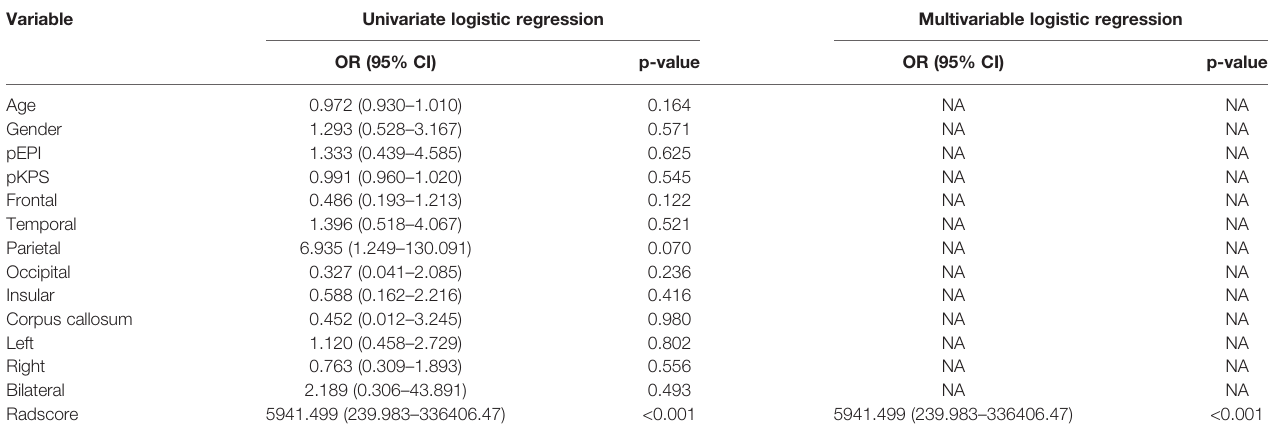
TABLE 4 | The results of logistic regression.